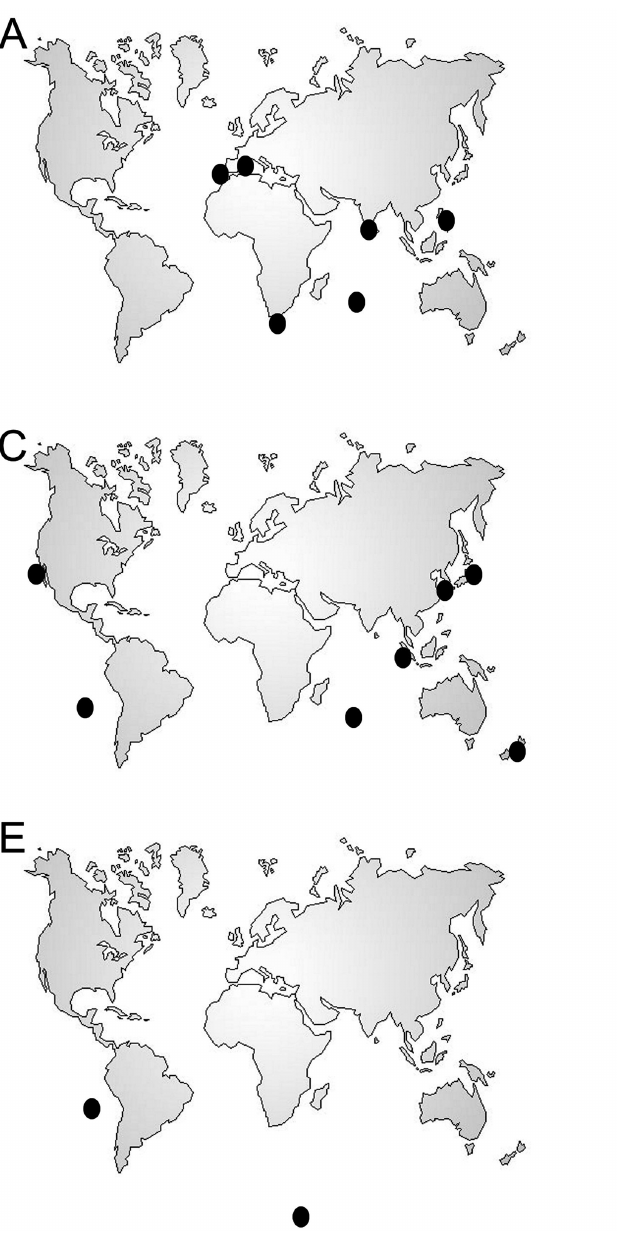
Fig . 5. – Approximate distribution of each assemblage in Poecillastra defined by shared sets of spicules. (A) species bearing dichotriaenes (6 spp.), (B) species with anatriaenes (3 spp.), (C) species with disproportionately long oxeas (length >200x width, 7 spp.), (D) species with two categories of microxea ( Characella -like, 5 spp.), (E) species bearing asterose microscleres reaching over 70 µm in diameter (2